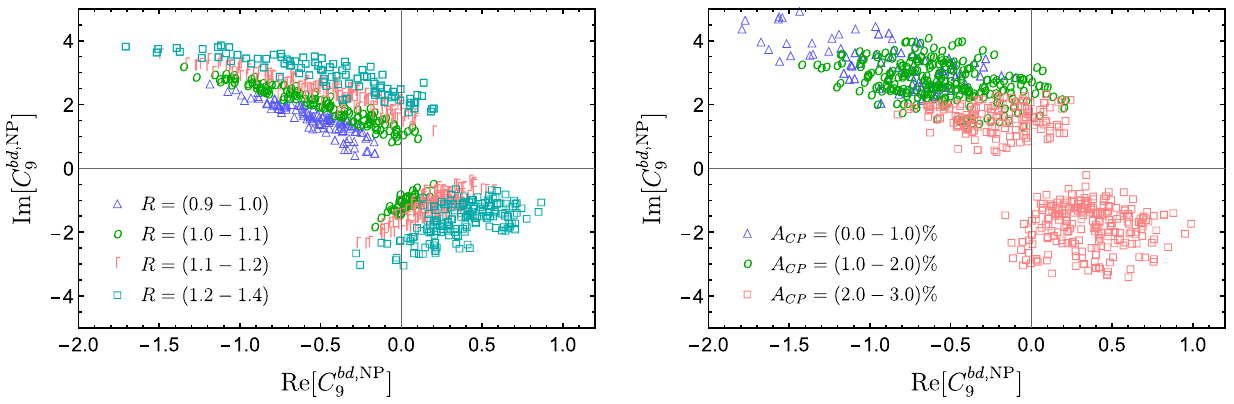
Fig. 8 The integrated values of the LFUV ratio R ( s ) (left panel) and the direct CP asymmetry A CP (right panel) in the 1 σ -favored parameter K ∗ ] , Im [ C bd , NP ] ) for the Z (cid:3) model with complex couplings space of ( Re [ C bd , NP 9 9 Figure7shows A CP ( q 2 ) inthelow- q 2 regionforthedecay ¯ K ∗ μ + μ − , considering the benchmark scenarios NP1 B s → and NP2 (real couplings), as well as NP3 and NP4 (complex couplings). It can be seen from the left panel of the figure that for real couplings, A CP ( q 2 ) is either marginally below the SM prediction or almost consistent with